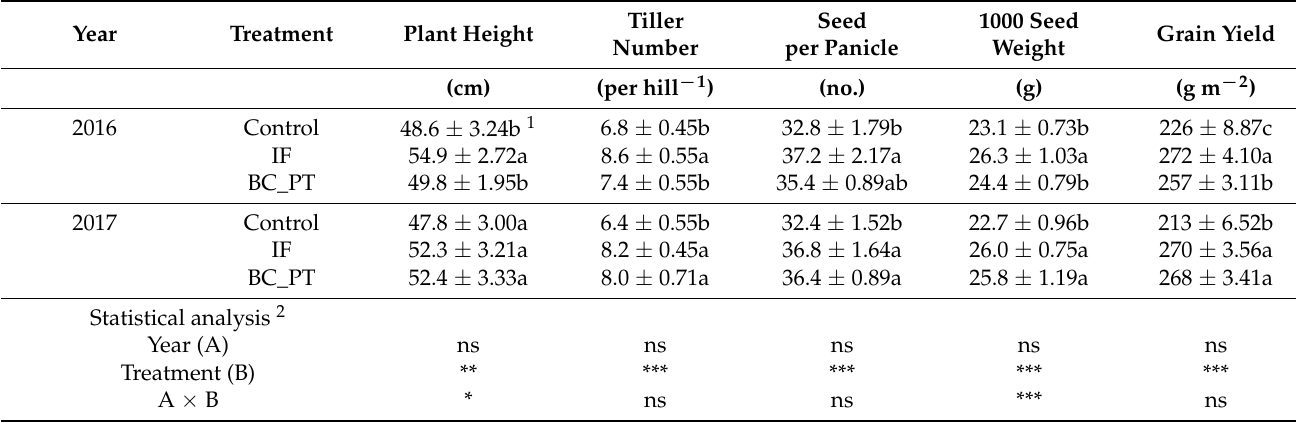
Table 2. Rice yield components in paddy soils.